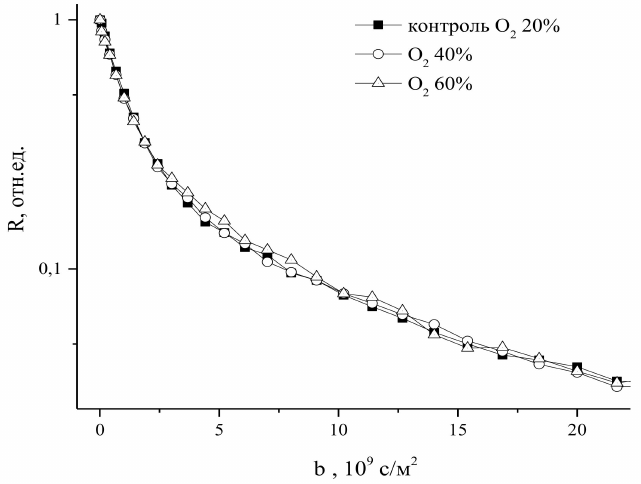
Figure 25. Diffusion decays of water magnetization in cells of intact corn roots in control and 30 min after an increase in the O 2 concentration in the leaf zone up to 40% and 60% under normobaric conditions in the atmosphere ( b = γ 2 δ 2 g 2 t d )